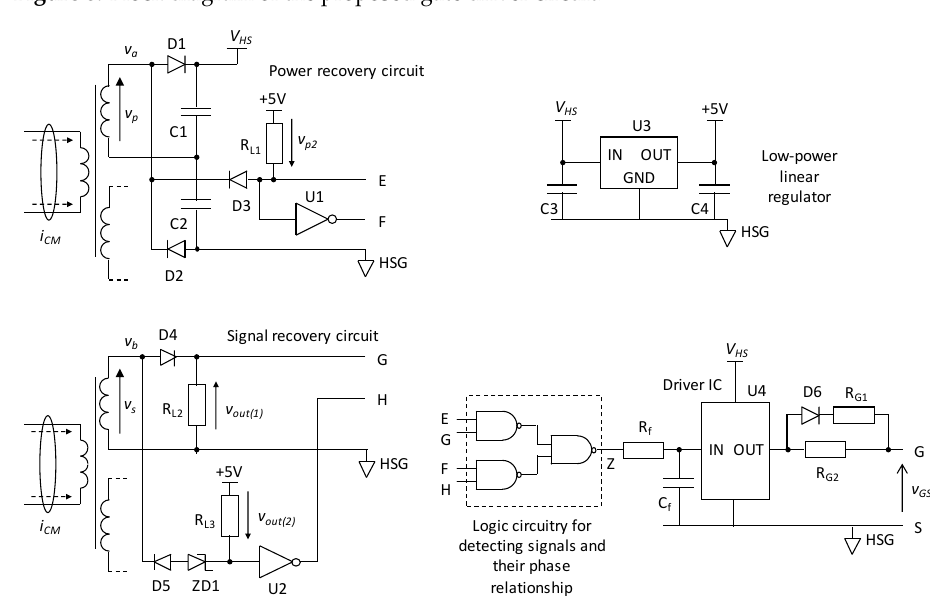
Figure 9. Arrangements for recovering the power and gate drive signals within each of the local driver circuits in Figure 8.